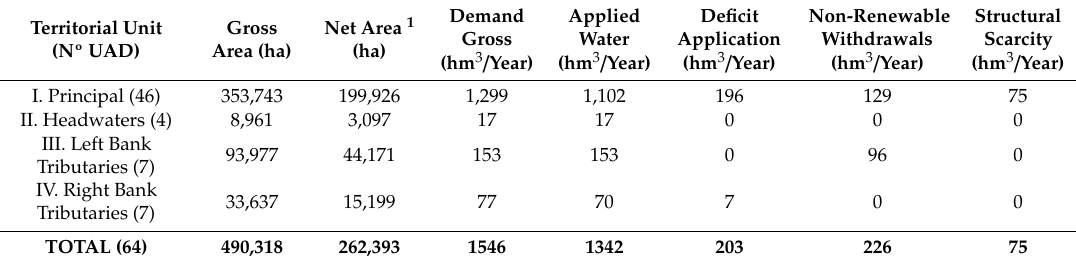
Table 1. Distribution by origin of the water for agricultural demand by TU (horizon 2015). Source: SDP